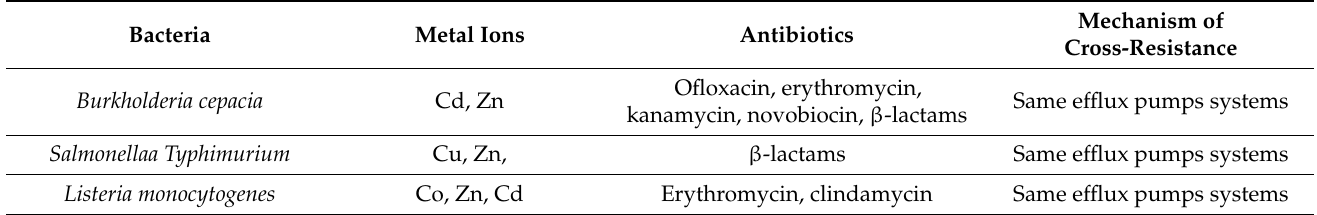
Table 1. Example of cross-resistance to both antibiotics and metals [10,27].